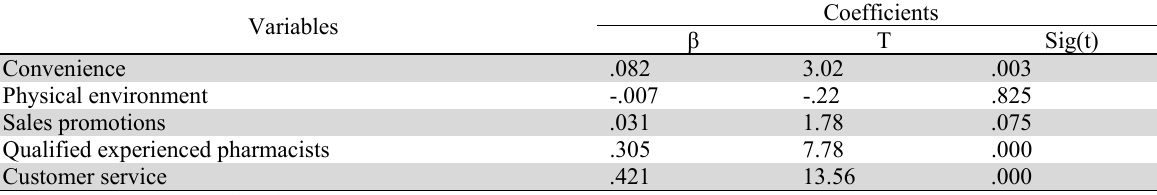
Multiple linear regression for testing the effect of the selected factors combined on pharmacies selection